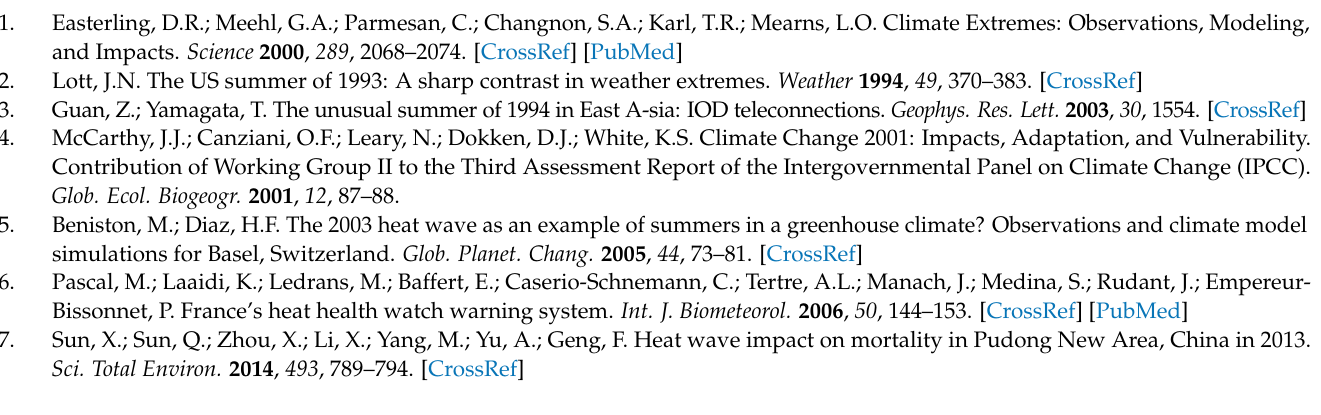
Here, F represents social vulnerability, and F 1 , F 2 , F 3 , and F 4 represent the scores of each principal component,